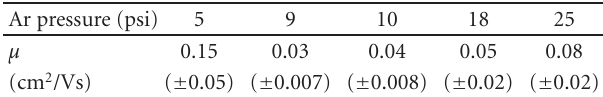
Table 1: Field-e ff ect mobility for diF TES-ADT devices spray- coated under various carrying gas